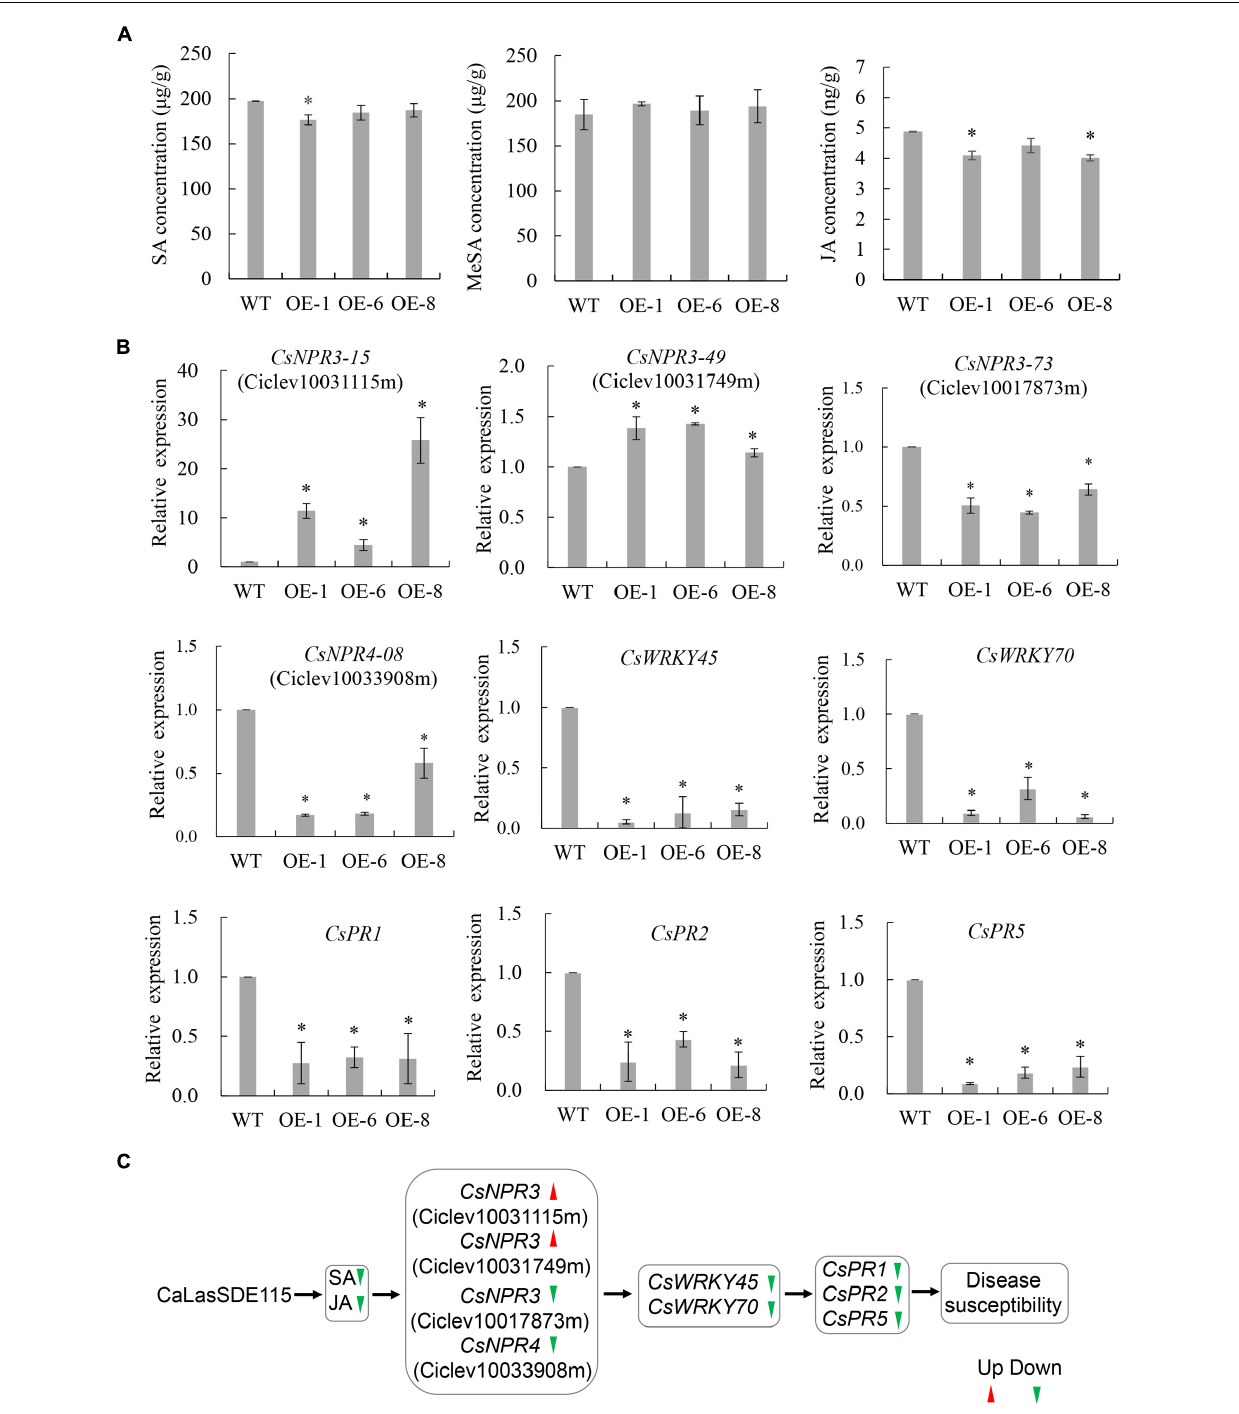
Frontiers in Microbiology |